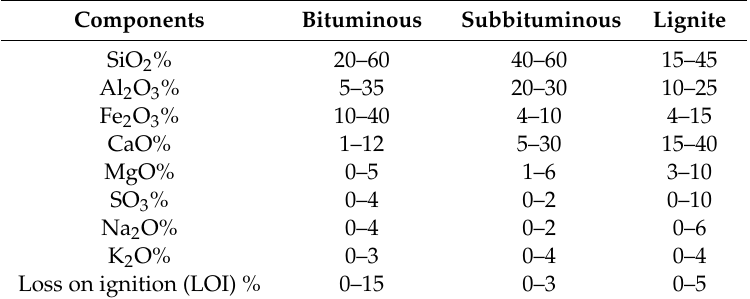
Table 1. Normal range of fly ash chemical composition produced from di ff erent coal types (in wt. %)